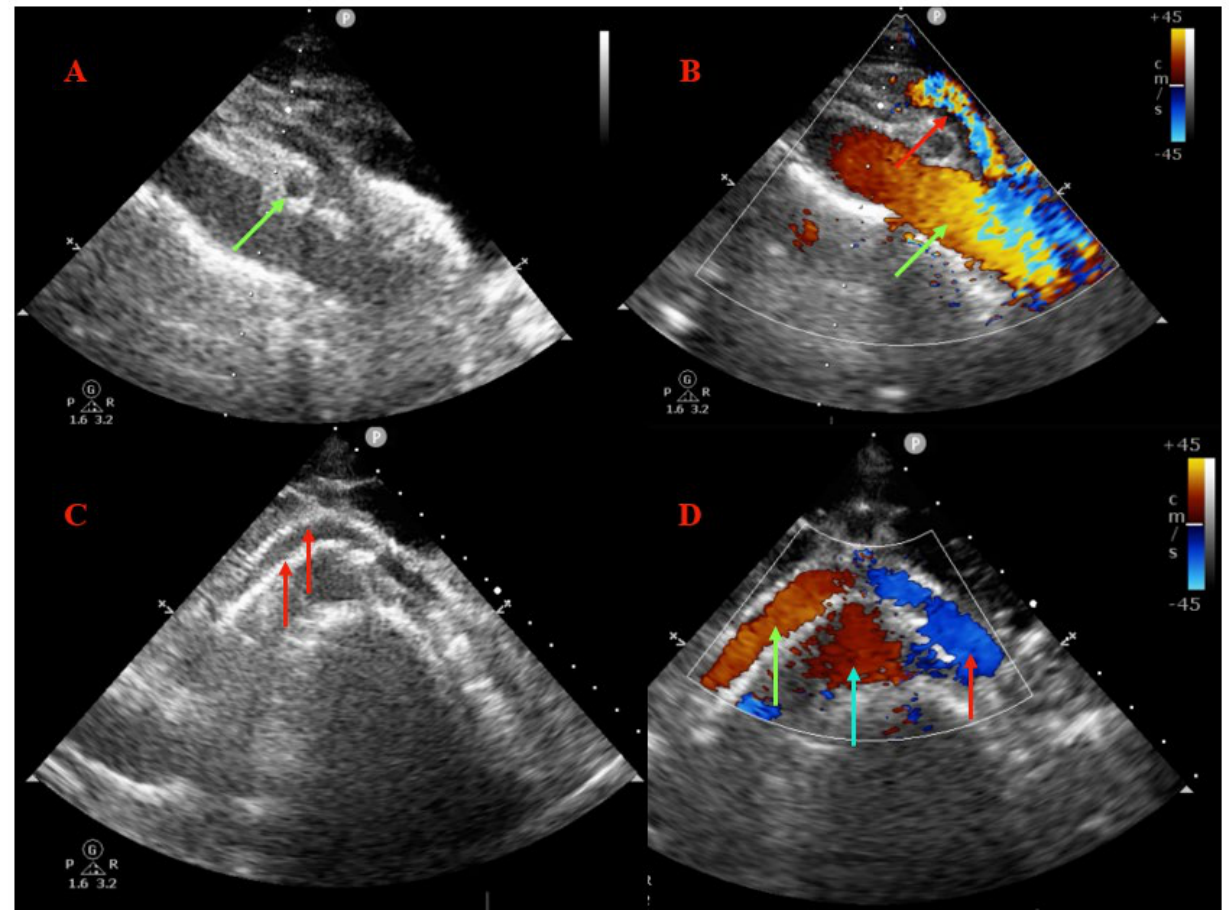
Figure 5. Abdominal ultrasound findings at the three-month follow-up. ( A ) LRV short axis showing well-expanded and well-apposed stent (green arrow), with enlarged aortomesenteric space. ( B ) Doppler ultrasound showing regular aortic (green arrow) and mesenteric (red arrow) flow, with enlarged aortomesenteric space. ( C ) LRV long axis confirming good expansion and apposition of the vein stent (red arrows). ( D ) Doppler ultrasound confirming regular flow in the LRV (green arrow), inferior vena cava (red arrow), and aortic artery (blue arrow).